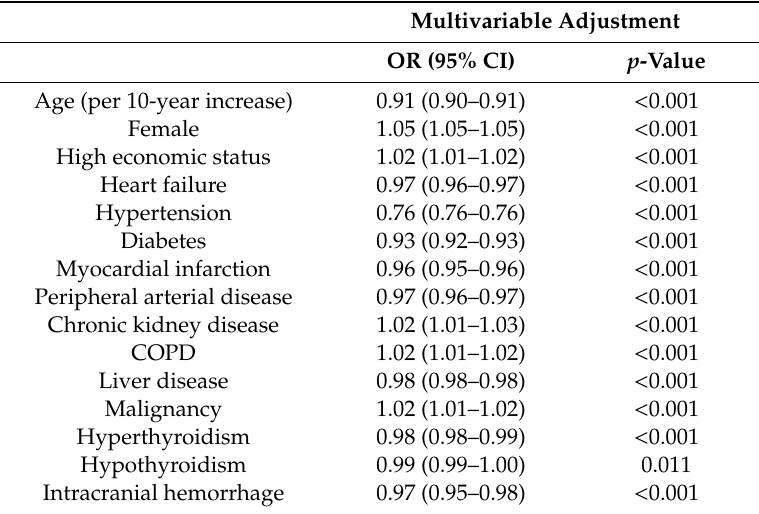
Table 2. Factors associated with the ABC pathway.